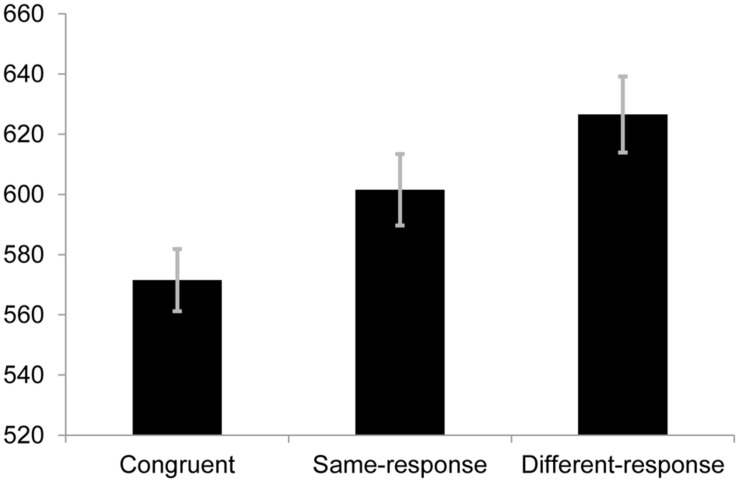
Mean response times (RTs; in ms) for each condition in Experiment 1. Error bars represent SE.